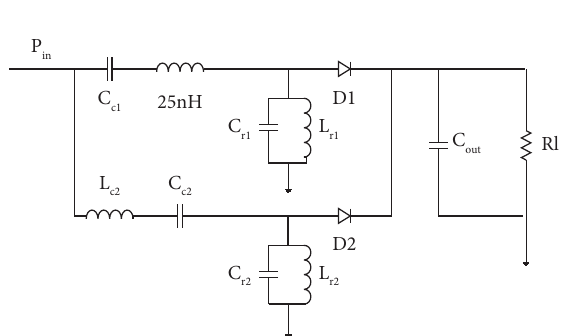
Figure 19: Rectifer adopting the design of Figure 18.